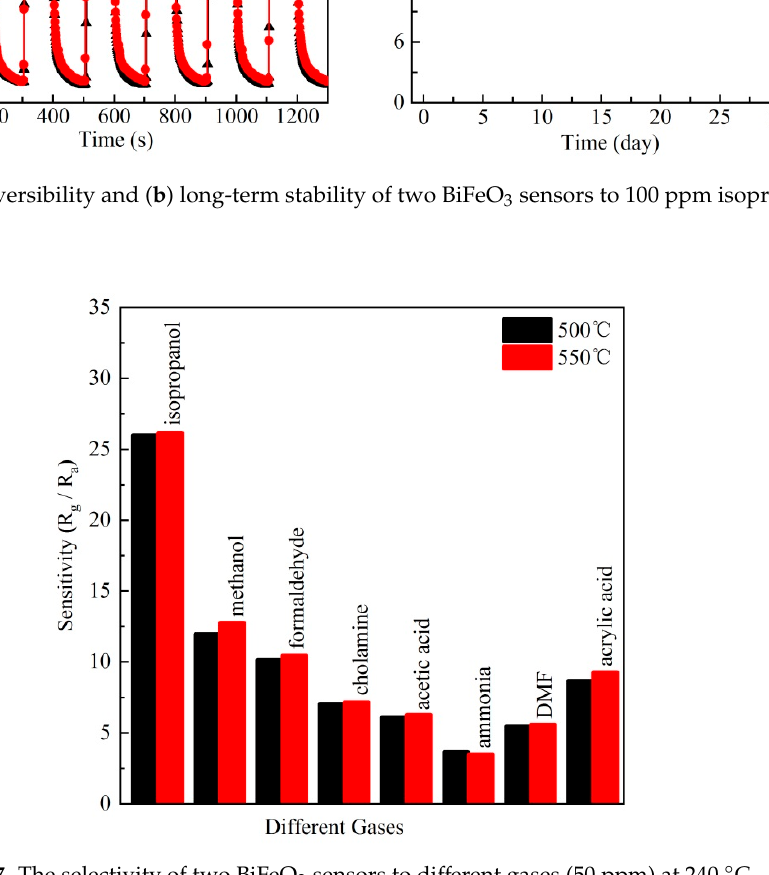
Figure 7. The selectivity of two BiFeO 3 sensors to different gases (50 ppm) at 240 °C.